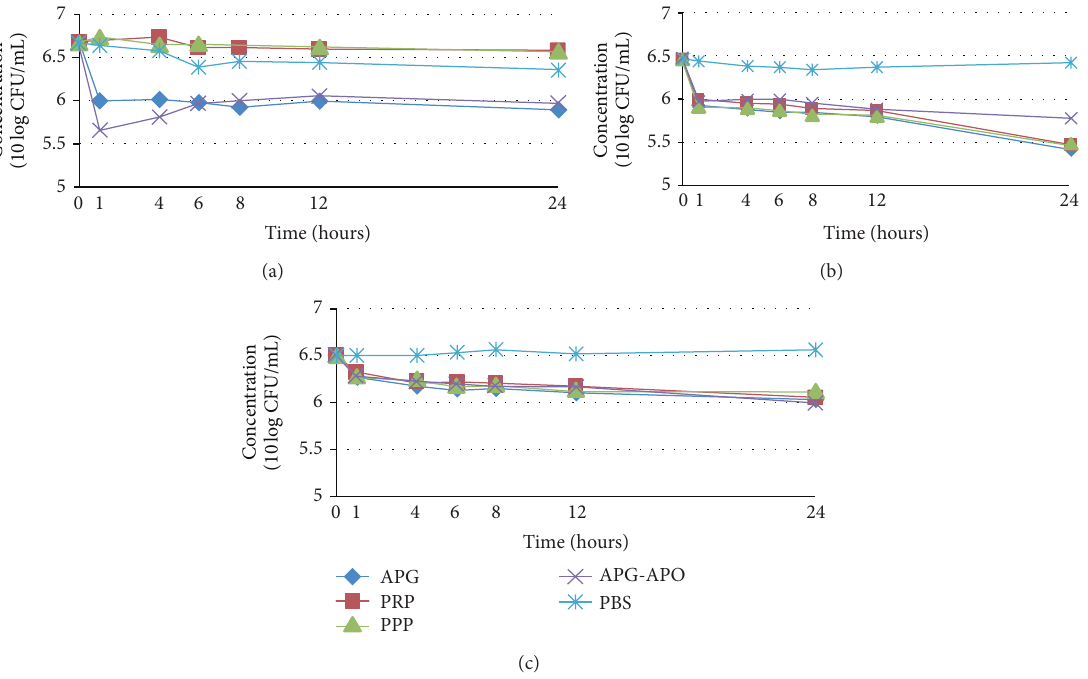
Figure 1: Effect of APG on the counts of various bacteria ((a) Staphylococcus aureus ; (b) Escherichia coli ; (c) Pseudomonas aeruginosa ). APG: autologousplatelet-richgel;APG-APO:APGcombinedwithapocynin;PRP:platelet-richplasma;PPP:platelet-poorplasma;PBS:phosphate- buffered saline.